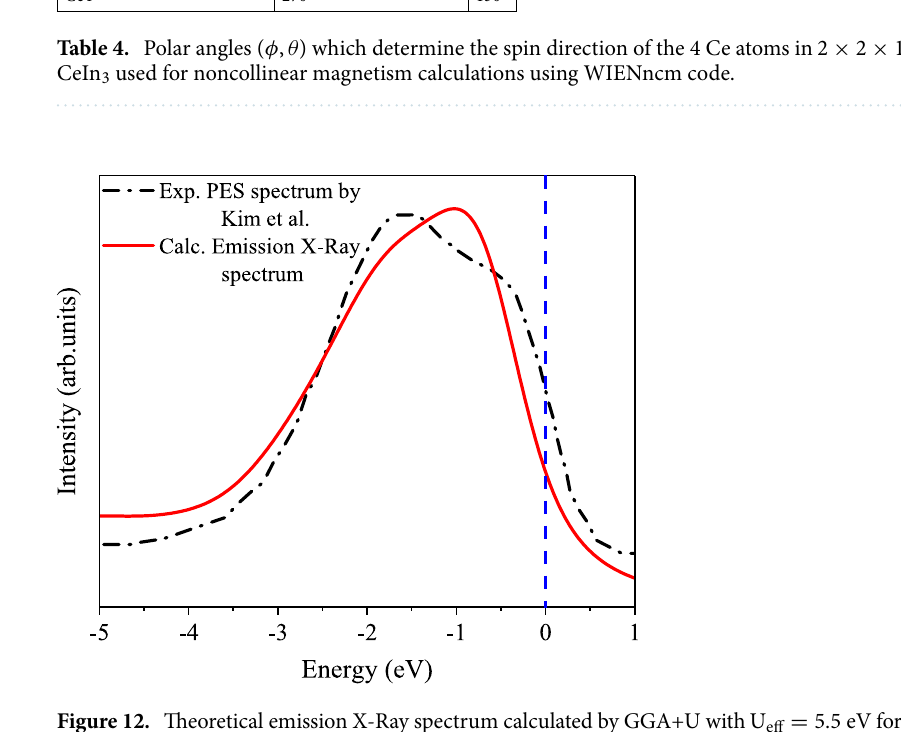
Figure 12. Theoretical emission X-Ray spectrum calculated by GGA+U with U eff = 5.5 eV for theAFM phase of CeIn 3 along with the experimental photoemission spectroscopy (PES) spectrum 84 .The vertical dash line in figure indicates the Fermi